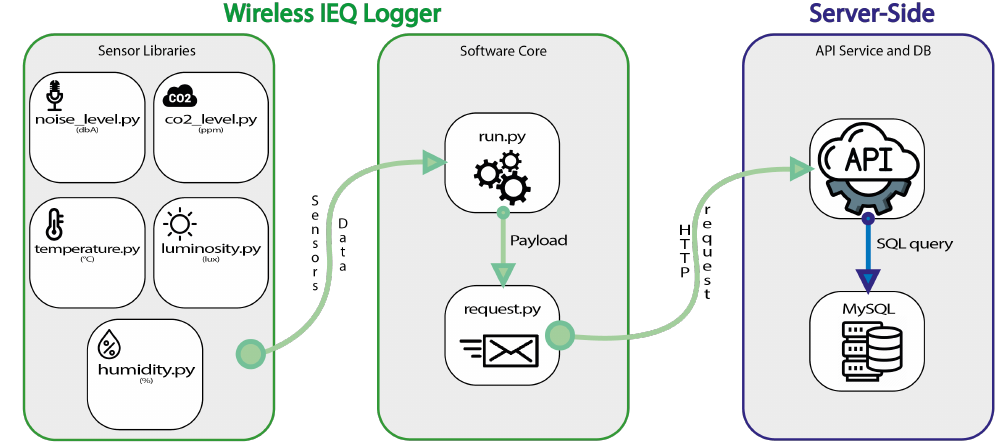
Figure 4. Wireless IEQ logger: software